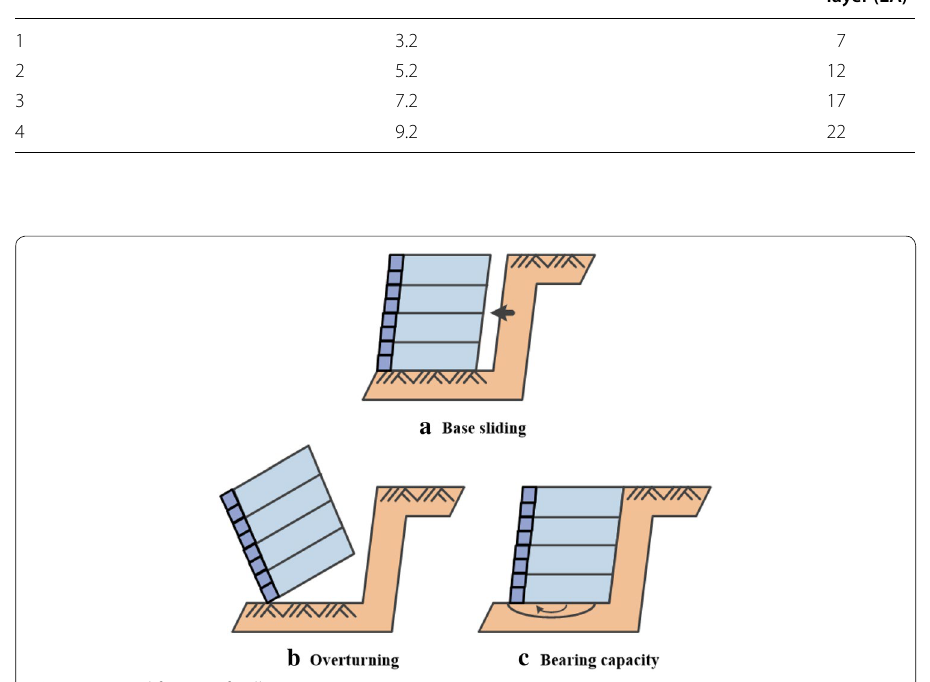
Table 1 Cases of various heights